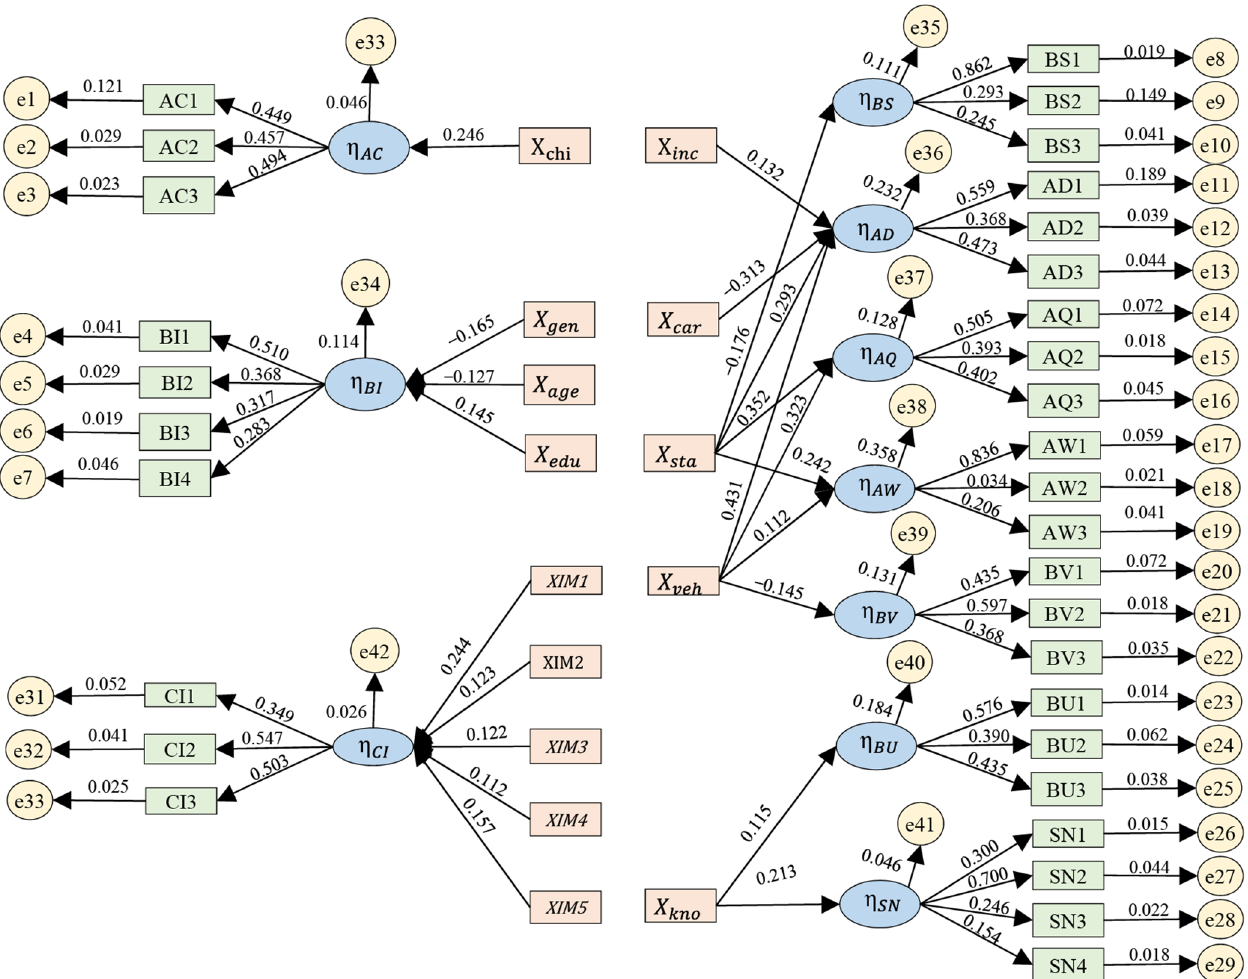
Figure 4. The relationship between exogenous variables and latent variables.